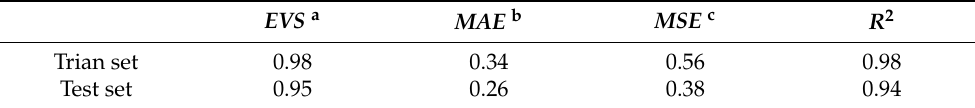
Table 2. Prediction accuracy statistics of train set and test set.